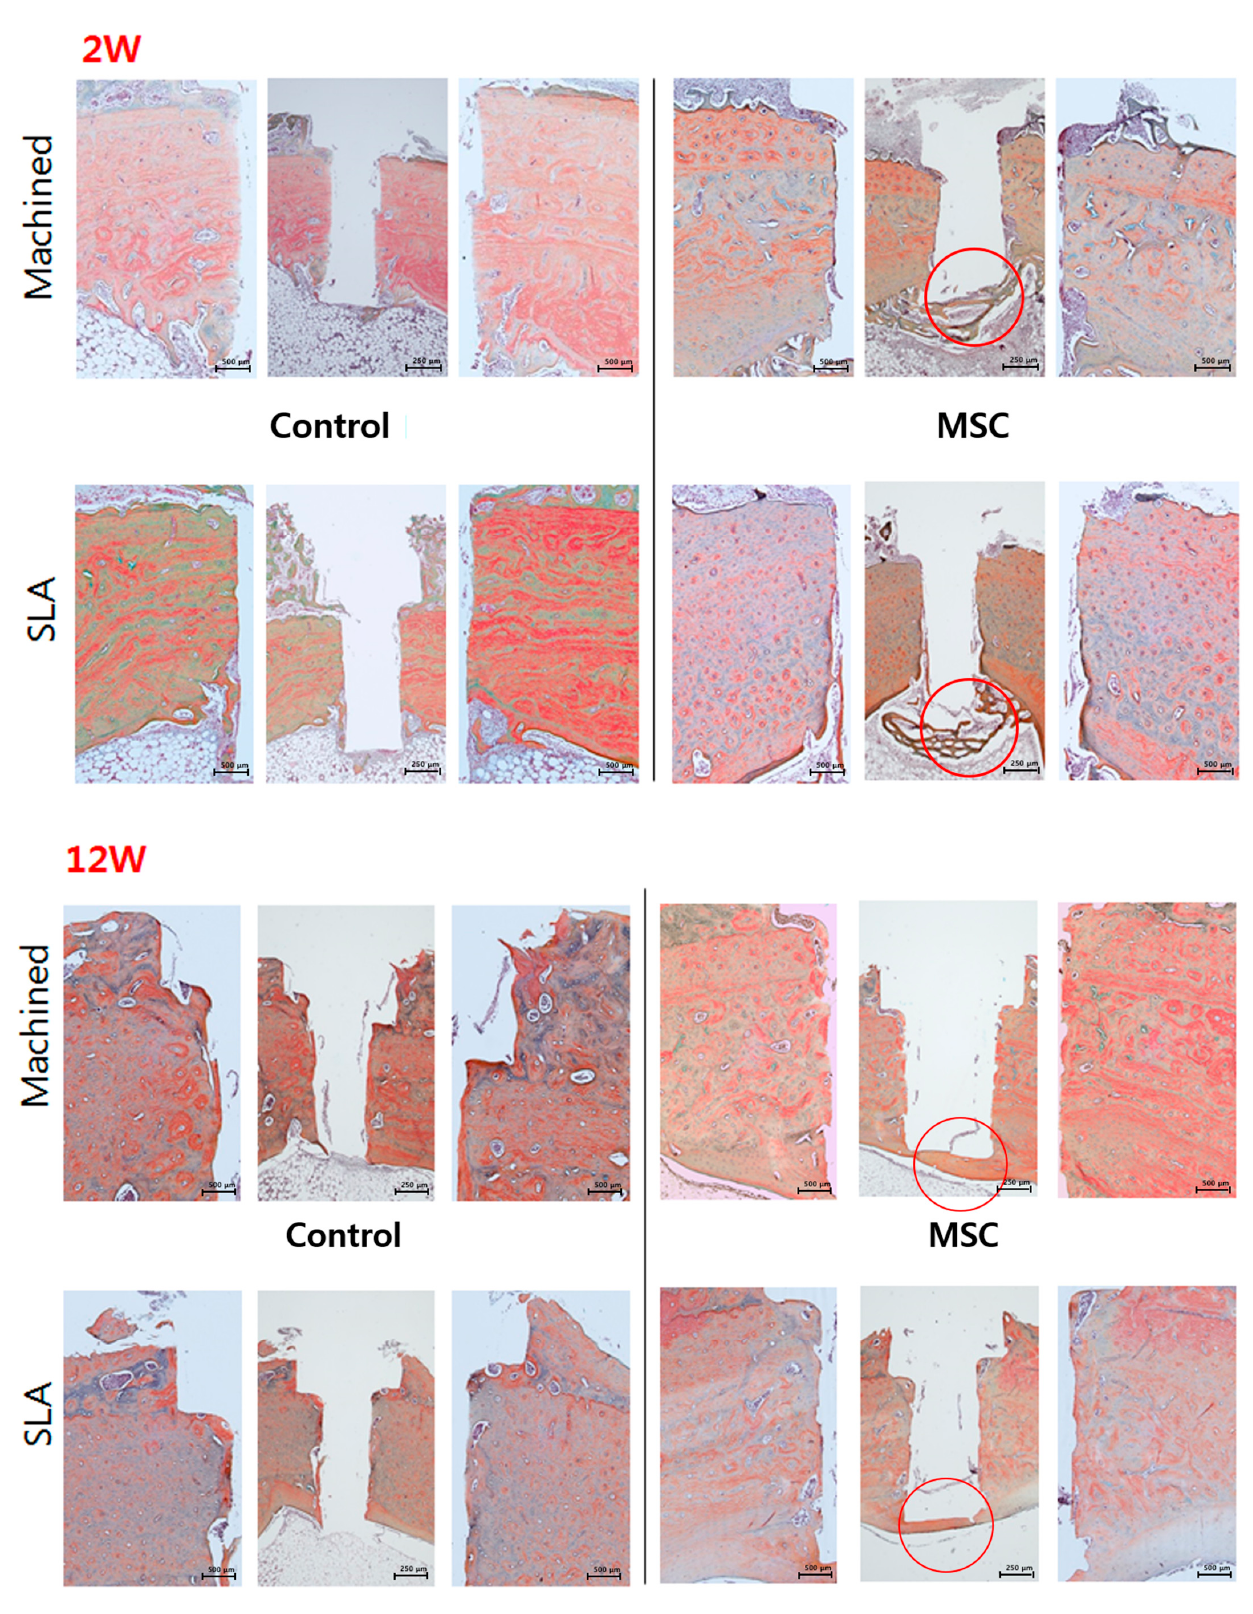
Figure 9. Light-microscopy views of the control group (without d-hMSCs) and the d-hMSCs group sacrificed at 2 and 12 weeks post-surgery (Russell–Movat pentachrome stain; original magnification ×50, ×100).